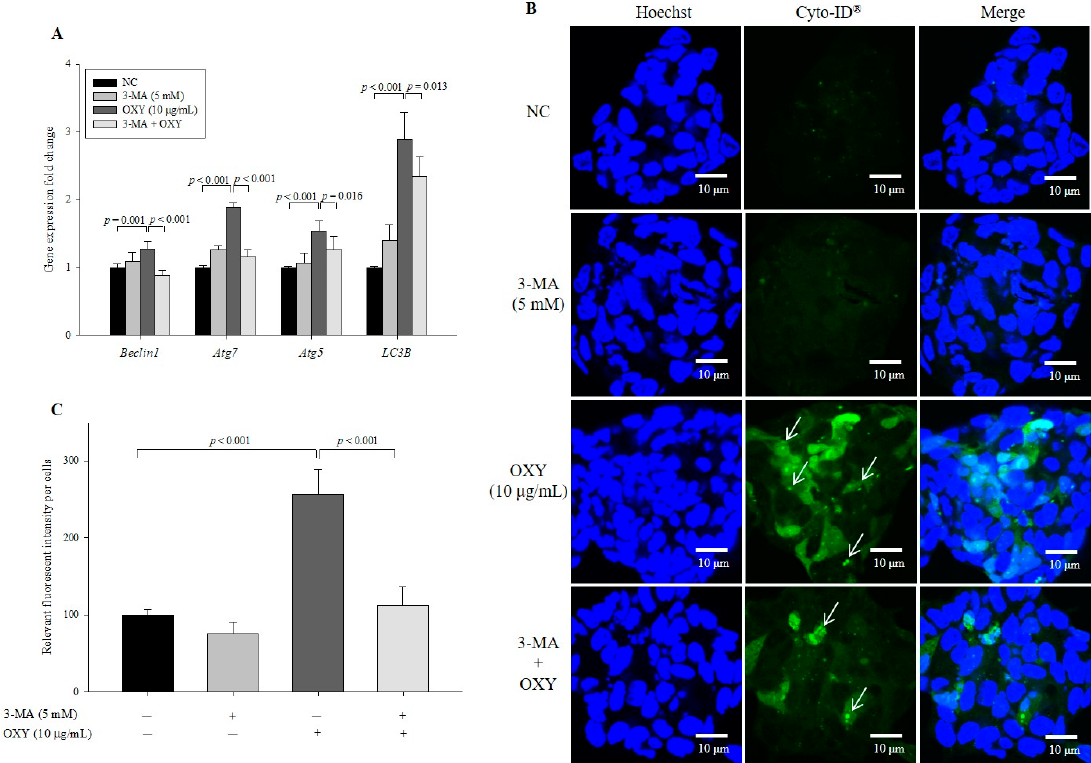
Figure 4. Effect of an autophagy inhibitor on OXY-induced autophagy. Cells were treated with OXY (10 µ g / mL) with or without the autophagy inhibitor 3-MA, and expression levels of autophagy-related genes were determined by qPCR ( A ). Autophagic vesicle formation was detected by the CYTO-ID autophagy green dye, as observed by fluorescence microscopy; white arrows indicate autophagosomes (magnification 600 × ) ( B ), which were quantified ( C ). Each value indicates the mean ± SD of three independent experiments performed in